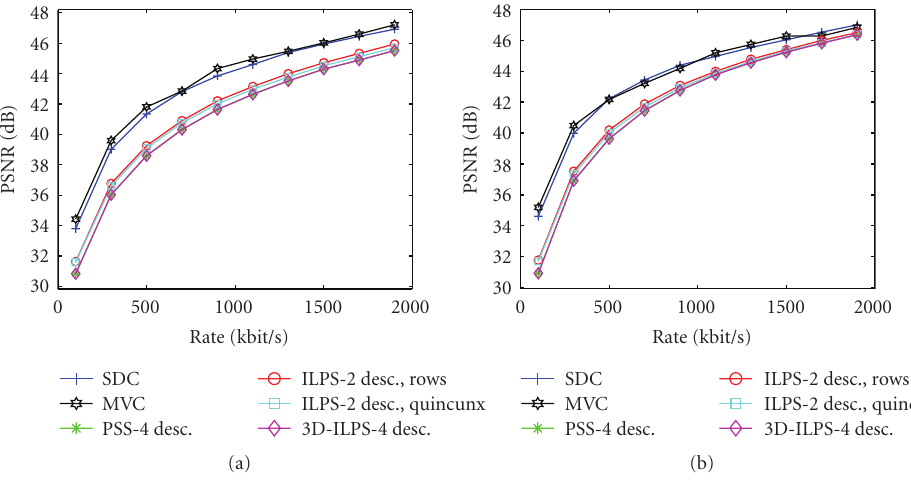
Figure 11: Performance of left view, four subsequences received. (a) Breakdance. (b)